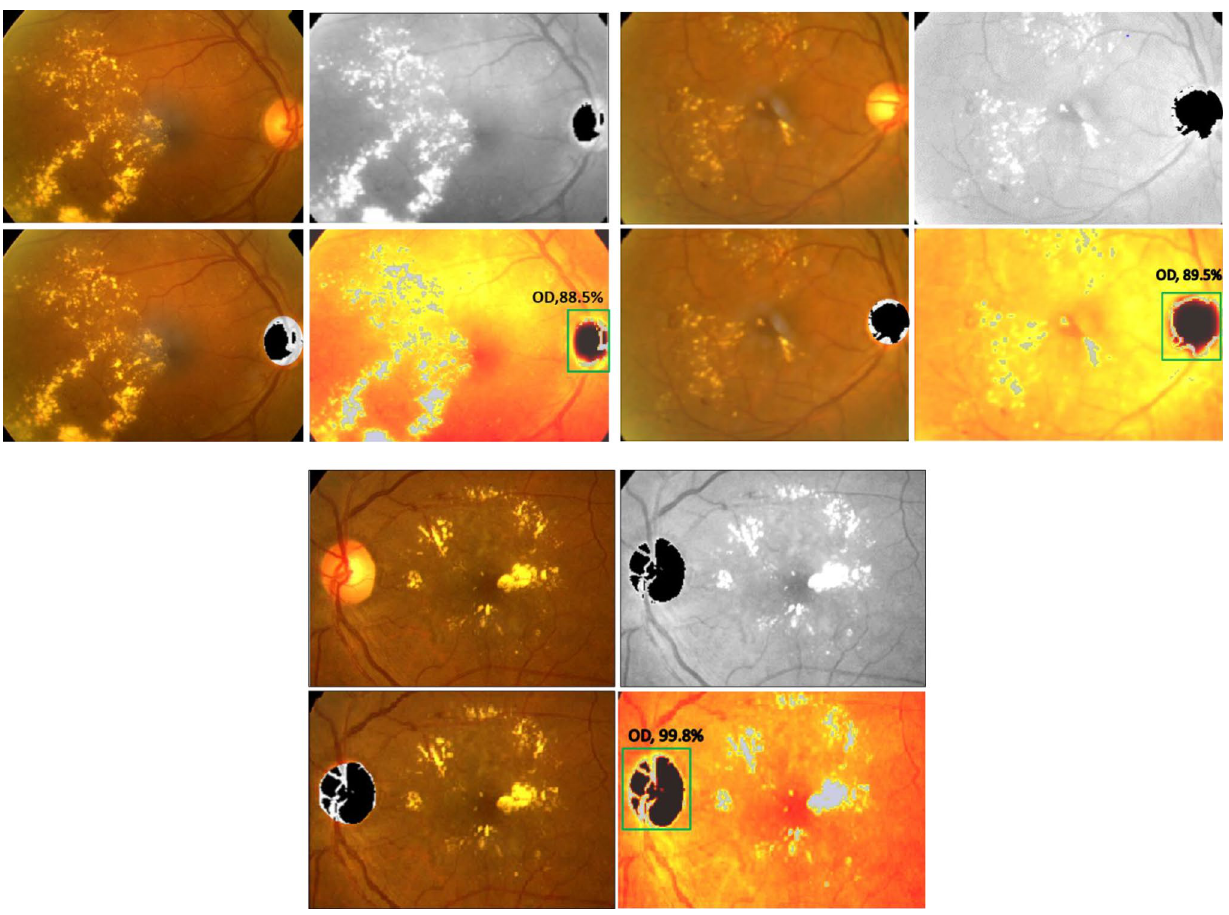
Figure 4. Weakly Supervised Sensitive Heat-map localization